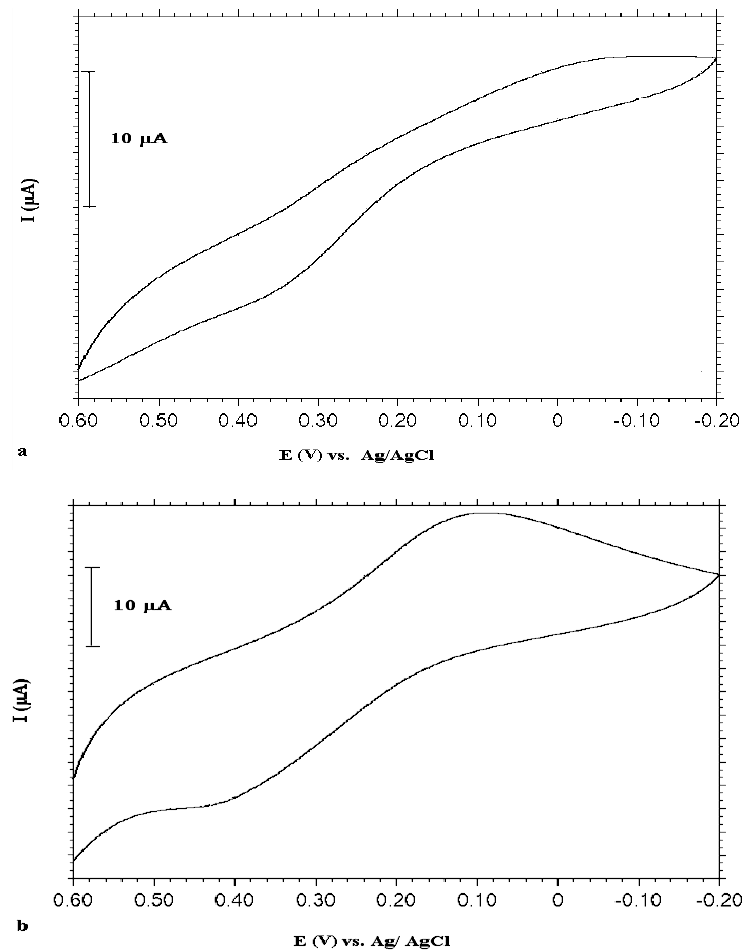
Figure 5. CVs of PANI ( a ) (deposited by CV method: 10 cycles) ( b ) (deposited by bulk electrolysis: at 0.9 V for 20 minutes) coated MB modified Au electrode in 0.1 M Fe(CN) 63−/4−